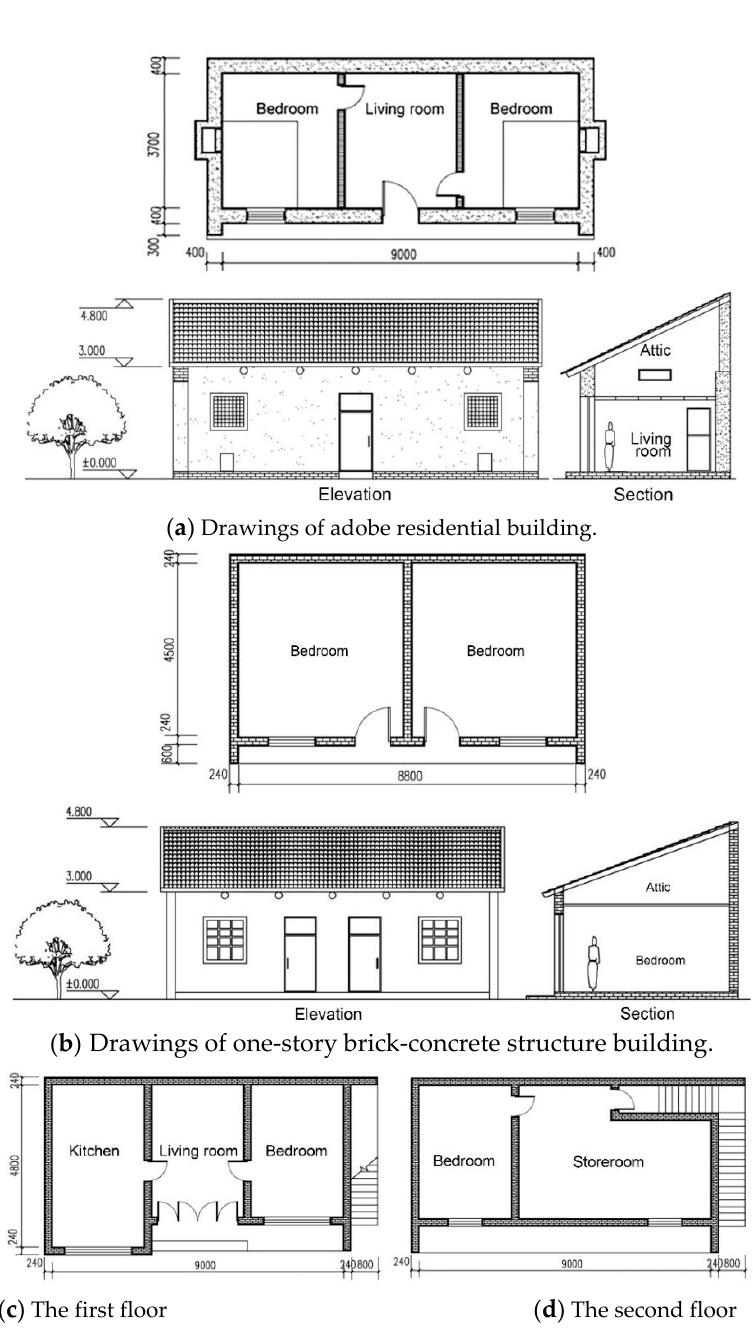
Figure A2. Drawings of three typical residential buildings. Table A2. Energy demand of manufacturing unit building materials and the waste proportion.